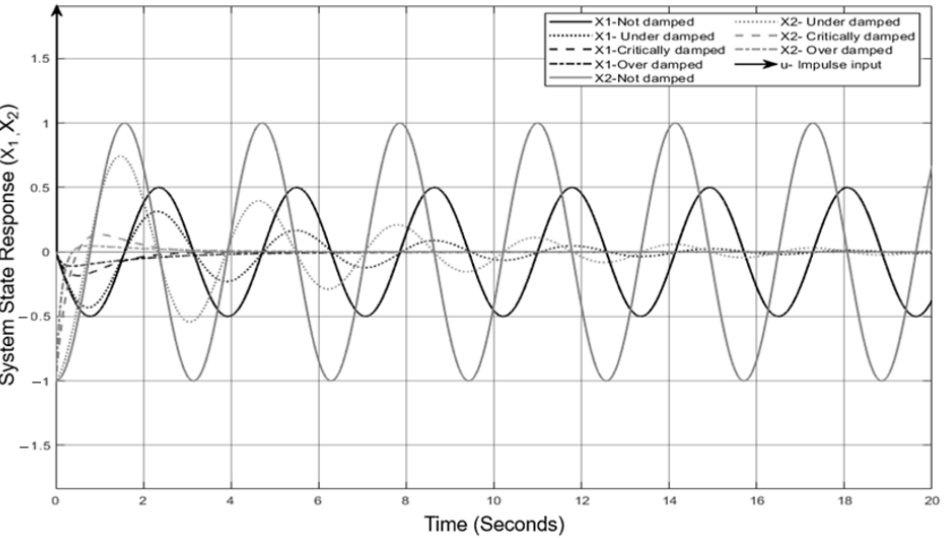
Figure 12. System state response under impulse input disturbance and [0, 0] initial conditions (Case example 1).